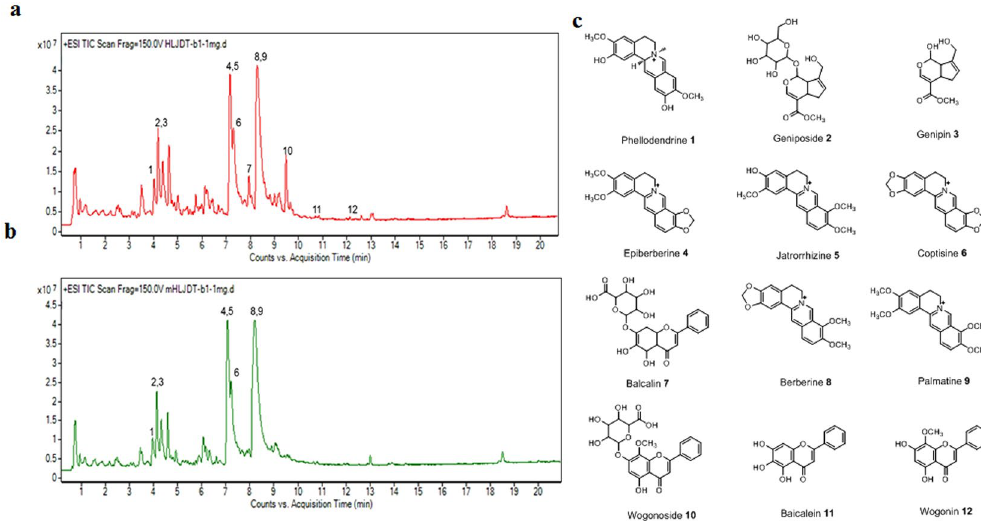
Figure 1. LC-ESI-Q/TOF chromatograms (TIC) of HLJDT ( a ) and HLJDT-M ( b ). ( c ). Chemical structure of representative compounds of HLJDT. Peaks: 1. Phellodendrine, 2. Geniposide, 3. Genipin, 4. Epiberberine, 5. Jaterorhizine, 6. Coptisine, 7. Baicalin, 8. Berberine, 9. Palmatine, 10. Wogonoside, 11. Baicalein, 12.